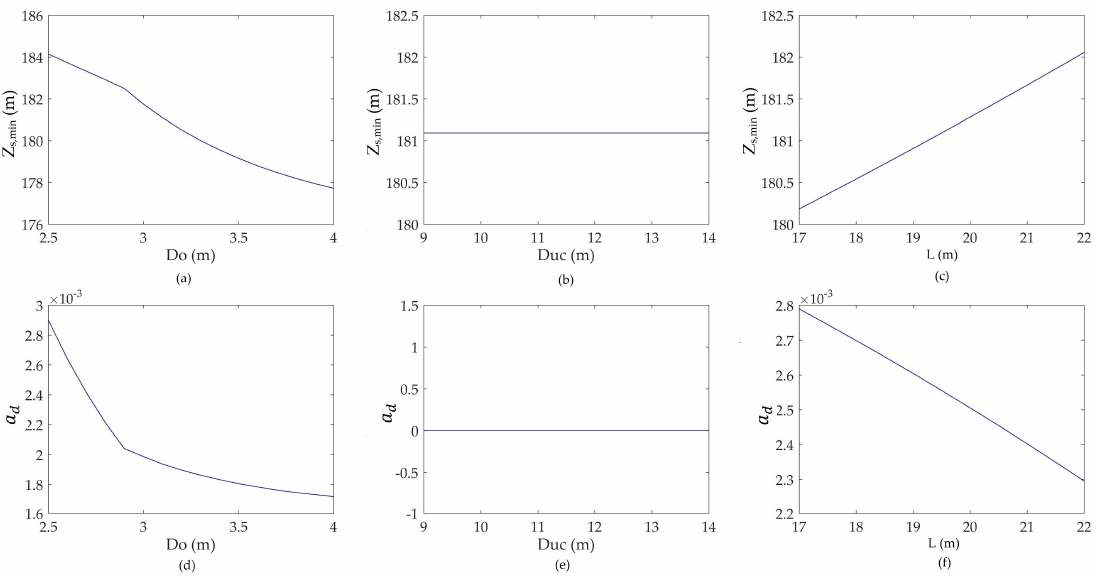
Figure 8. Minimum water level (a) , (b) , (c) and damping factor (d) , (e) , (f) for different diameters of orifice ( Do ), diameters of upper chamber ( Duc ), and length of lower chamber ( L ).